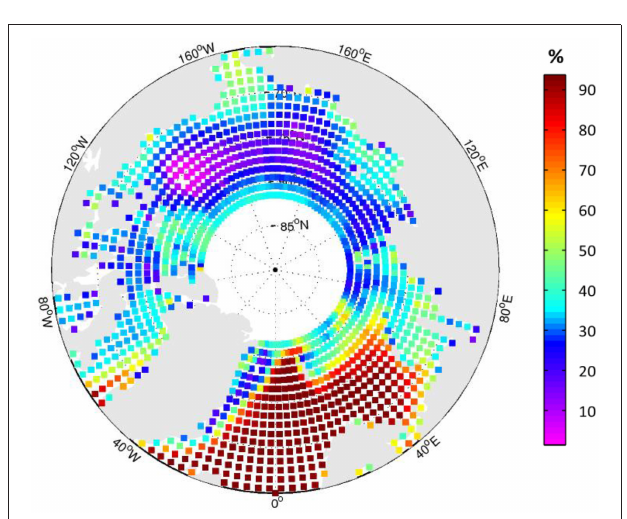
FIGURE 5 | Distribution of steric values available for period